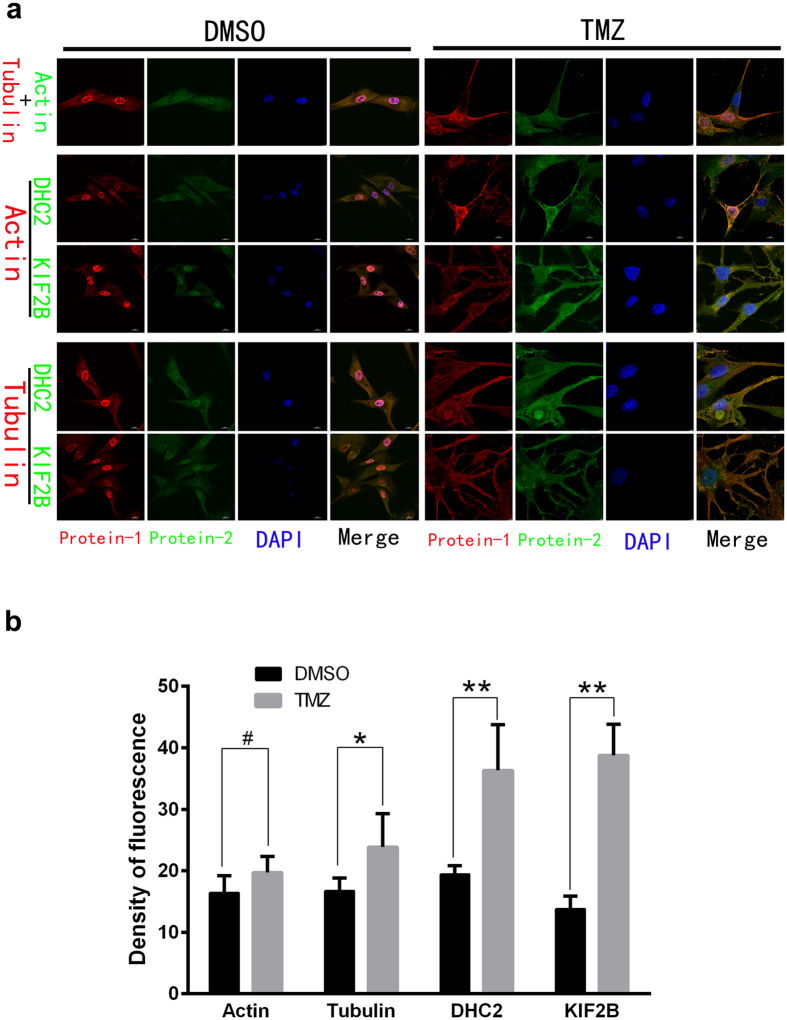
Effects of temozolomide on regulation of skeleton and skeleton-related protein expression in GBM cells.(a) Rearrangement and damage of skeleton and immunofluorescence analysis of Actin, Tubulin, DHC2 and KIF2B in U87 cells after treatment with temozolomide/DMSO for two weeks. Magnification, ×1200. (b) Summarized data of immunofluorescence about these proteins (#P > 0.05; *P < 0.05; and **P < 0.01).